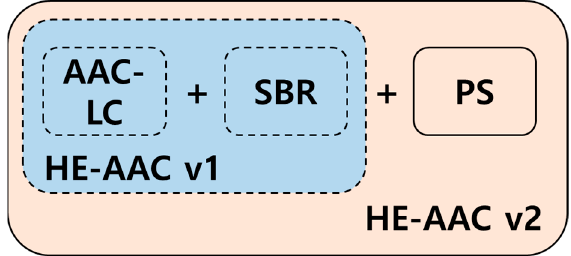
Figure 1. HE-AAC Figure 1. HE-AAC techniques